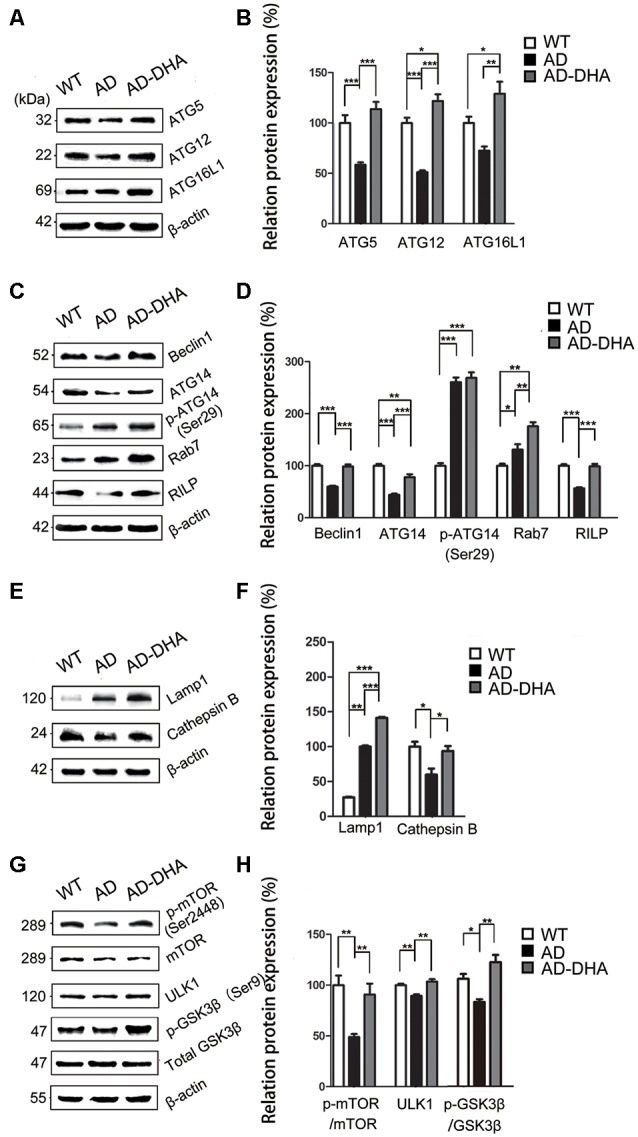
DHA increases the basal level of autophagy. Protein levels of ATG5, ATG12, ATG16L1, Beclin1, ATG14, p-ATG14 (Ser29), Rab7, RILP, Lamp1, CTSB, p-mTOR(Ser2448), mammalian target of rapamycin (mTOR), ULK1, p-GSK3β (Ser9), GSK3β in extracts of whole brain tissue were detected by WB. Representative Western blots are presented in panels (A,C,E,G), and quantification of the results is shown as the mean values ± SD in panels (B,D,F,H). *p < 0.05, **p < 0.01, and ***p < 0.001 between two groups. One-way analysis of variance/Newman–Keuls test was performed for all WB data.